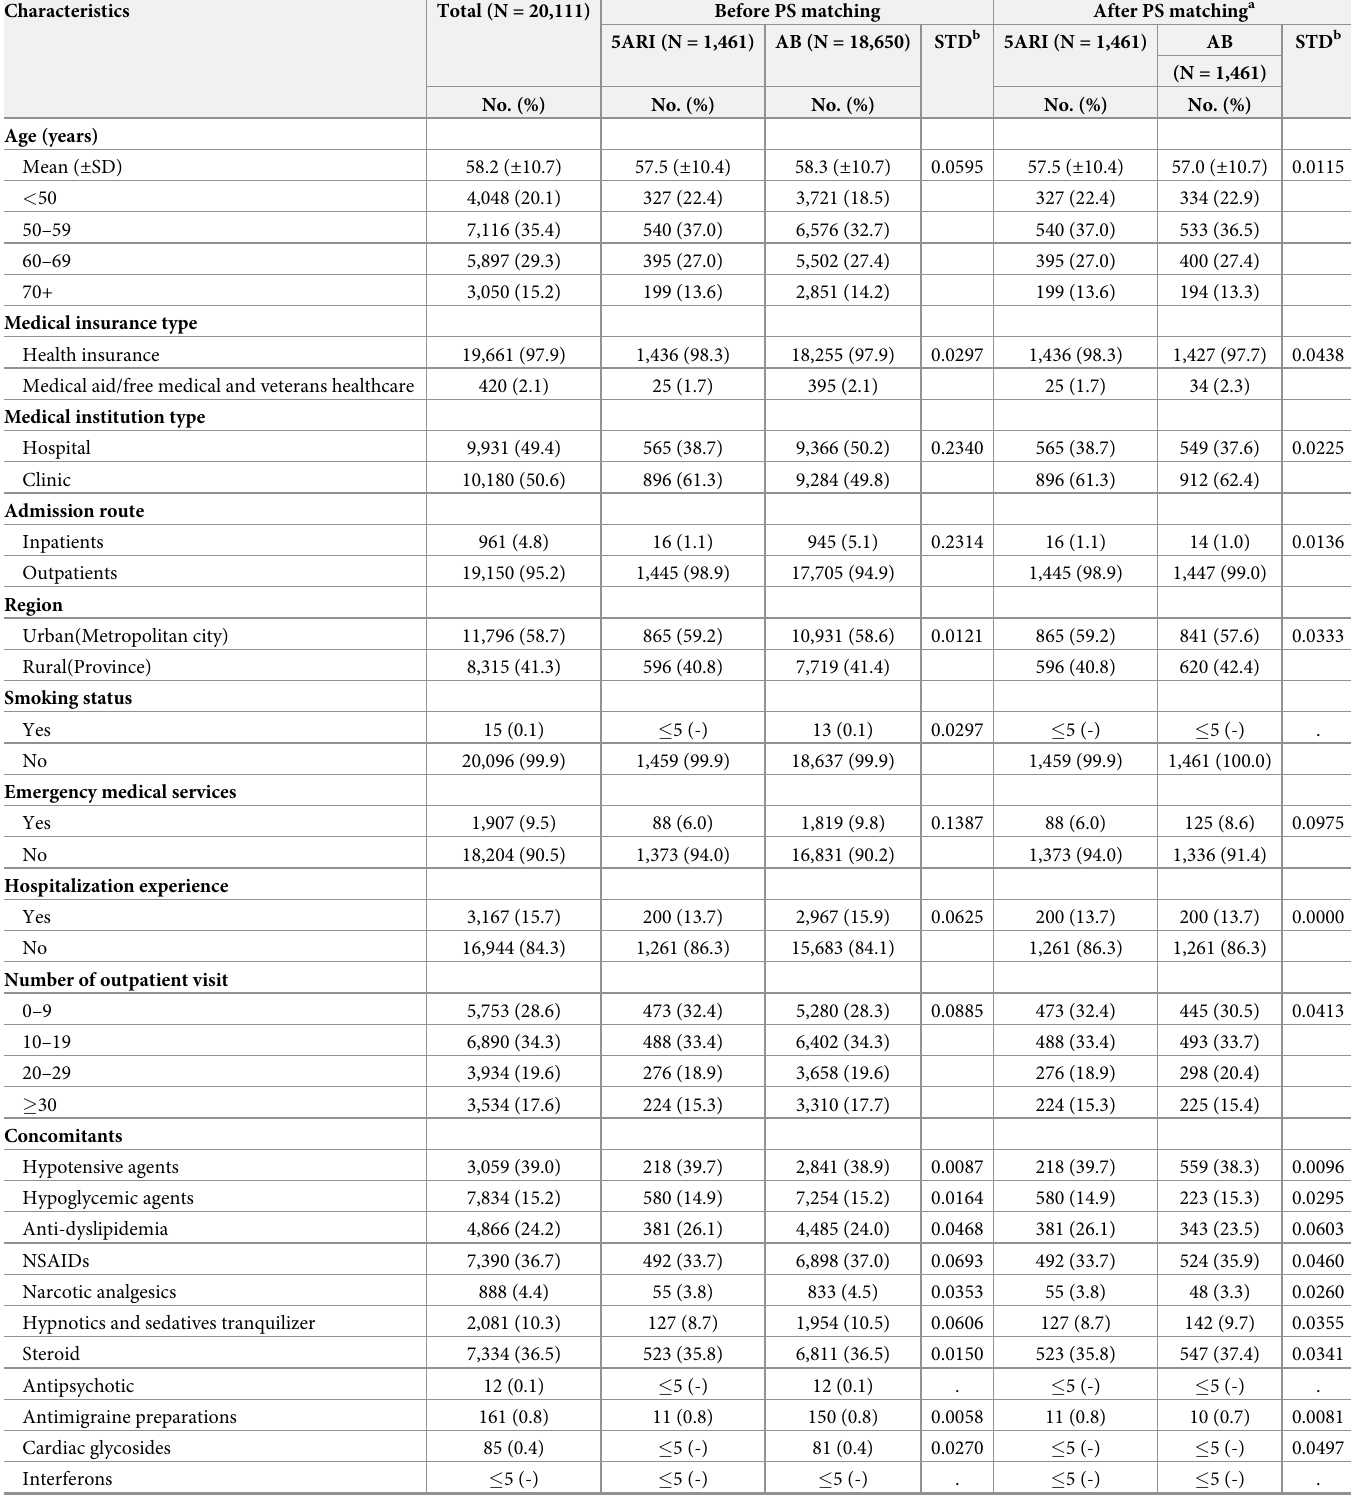
Table 1. Baseline characteristics of study population before and after PS matching in 2013.7–2015.6.